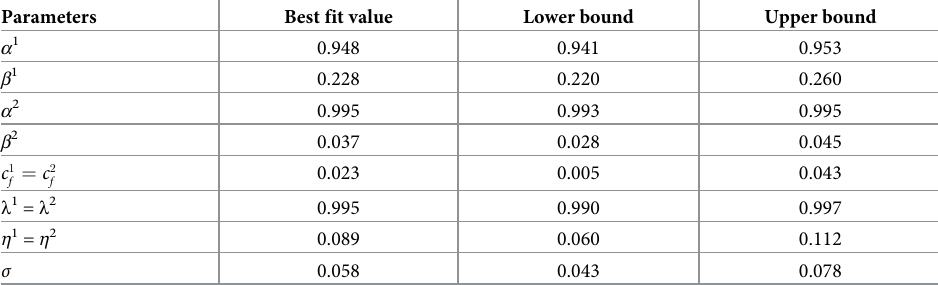
Table 2. Best fit parameter values for M8 with 95% confidence intervals.